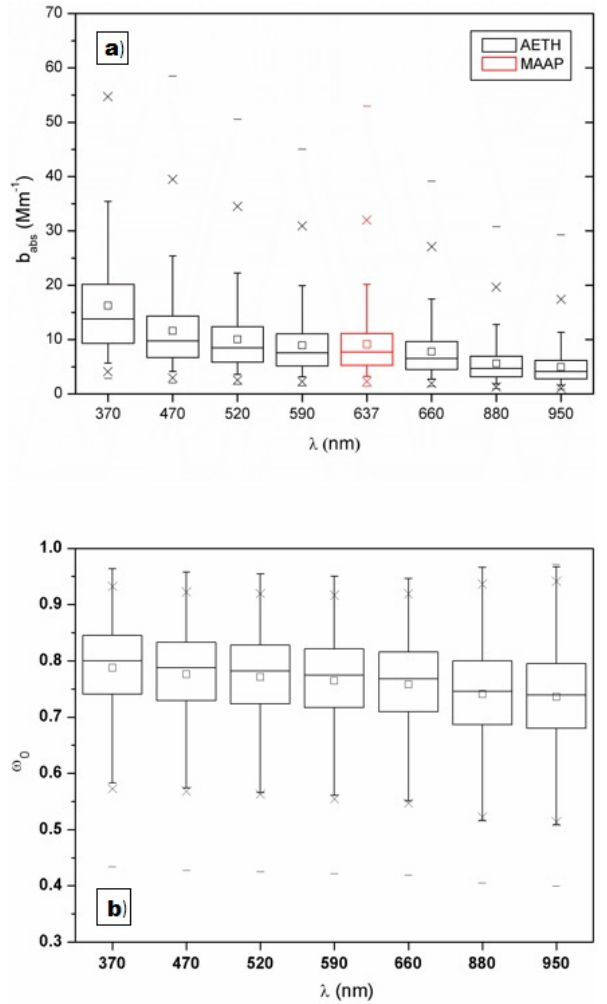
Figure 4. Whisker boxplot of (a) the Aethalometer (black) and MAAP (red) compensated absorption coefficients ( b abs ) and (b) single-scattering albedo ( ω 0 ) for the seven aethalometer channels. The square inside the boxes represents the average; the central line corresponds to the median; the edges of the box are the 25th and 75th percentiles; the whiskers correspond to 5th and 95th per- centiles; and horizontal lines outside the boxes correspond to max- ima and